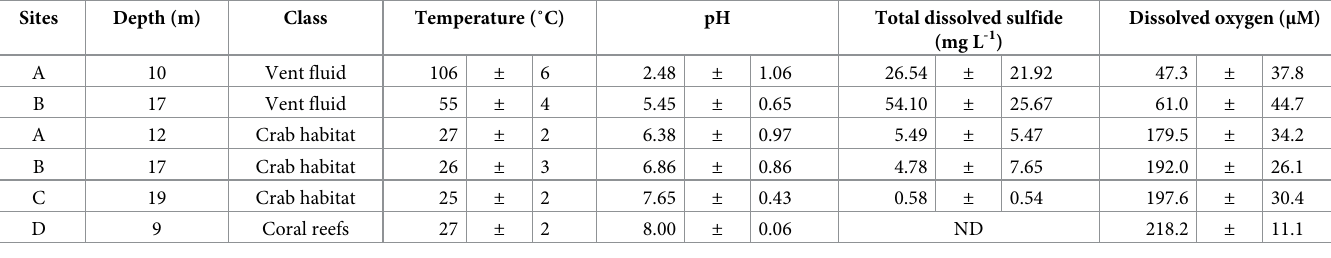
Table 1. Distributions of temperature, pH, DO and TDS in vent fluids and ambient sea water near Kueishan Island. Sites Depth